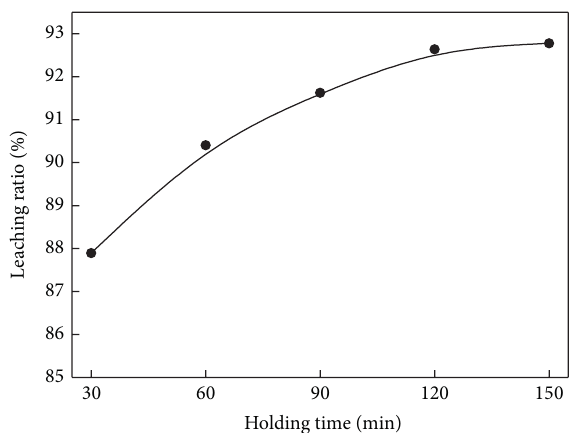
Figure 1: Alumina leaching ratio of 12CaO ⋅ 7Al 2 O 3 with different holding times.